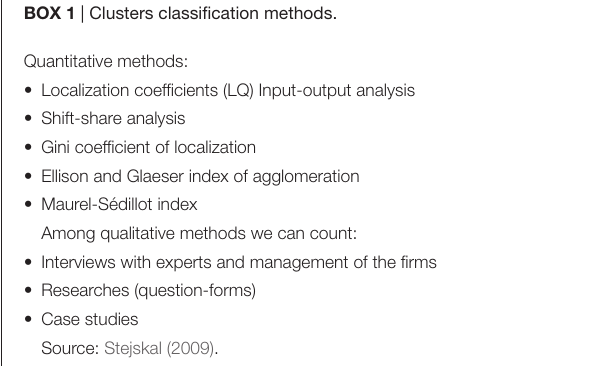
TABLE 1 | Porter Diamond model analytical framework. CONTEXT FOR FIRM STRATEGY AND RIVALRY